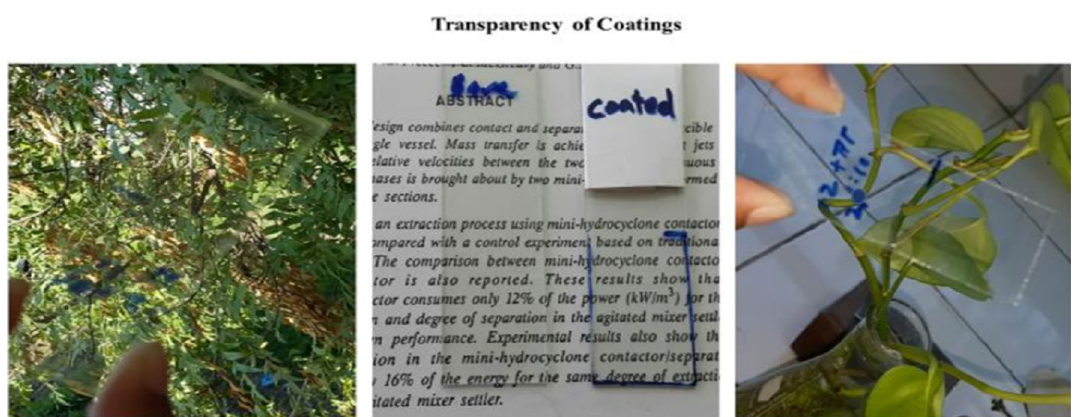
Figure 12. Transparency visualization of polymeric coatings.